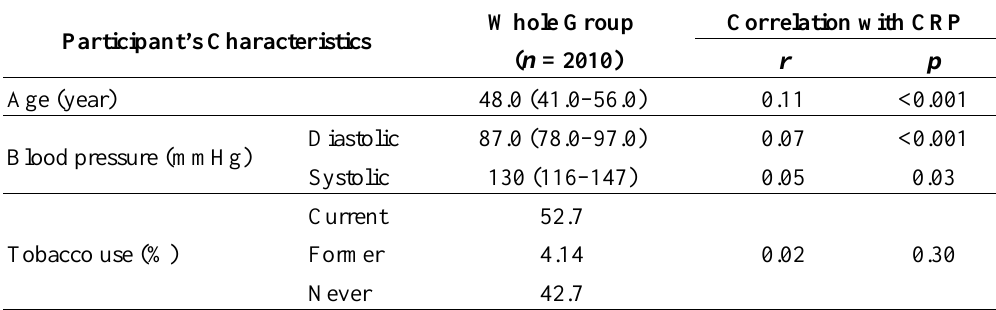
Table 1. Characteristics of the study